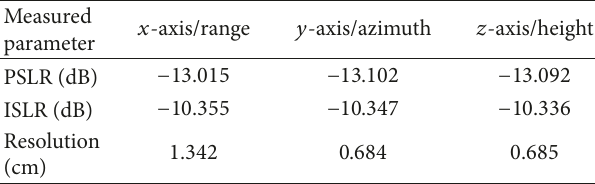
Table 2: The measured values of PSLR, ISLR and